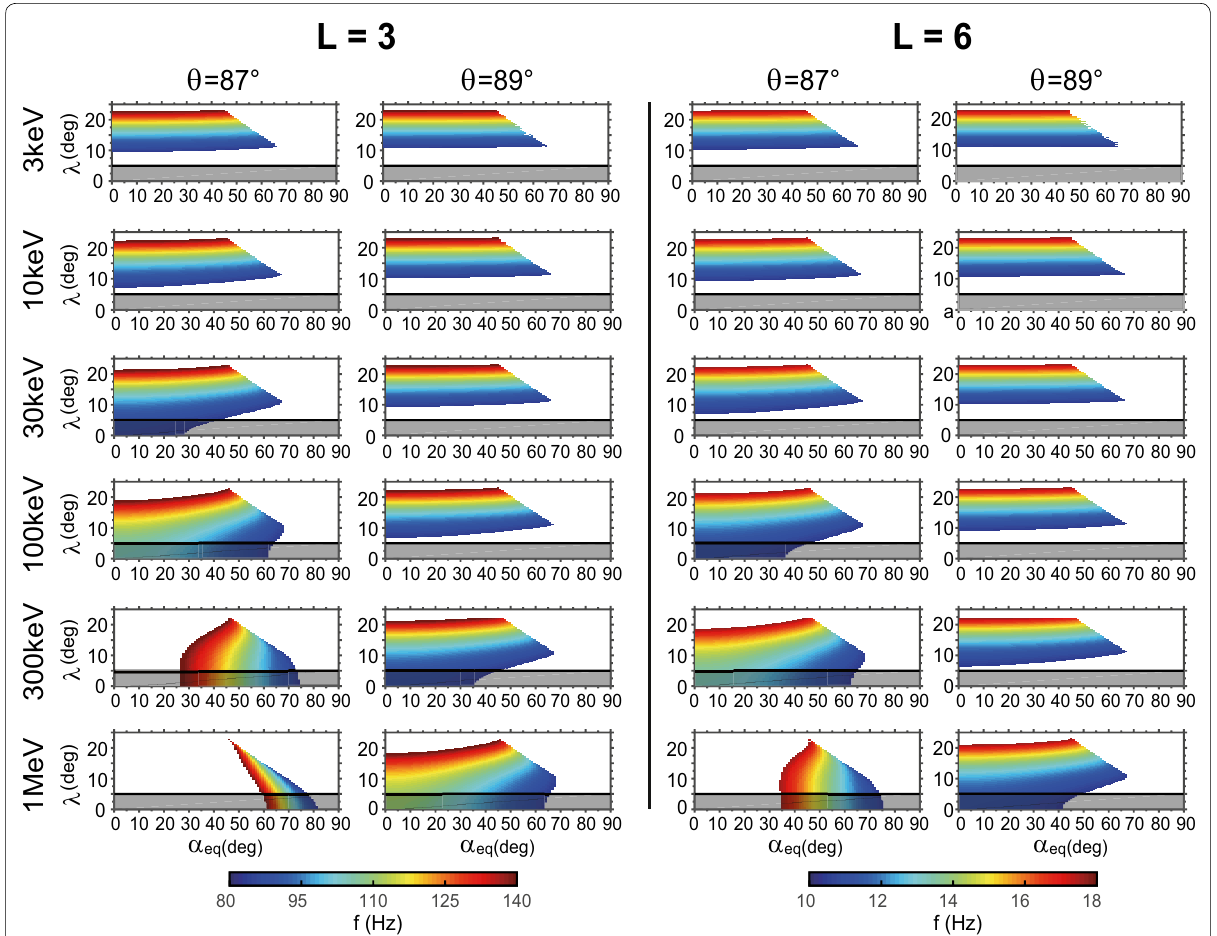
Fig. 4 Regions of resonance in (equatorial pitch angle α eq , magnetic latitude (cid:31) ) space for resonance ( n 4) between magnetosonic waves and = ring current protons at L 3 (inside the plasmasphere) and at L 6 (outside the plasmasphere) for six energies (from top to bottom: 3 keV, 10 keV, = = 30 keV, 100 keV, 300 keV, and 1 MeV) and for two wave normal angles (from left to right θ = 87 ◦ and θ = 89 ◦ ). The wave frequency band is adopted as 0.0026 < ω/(Ω ce ) eq < 0.0044, corresponding to a frequency range of 83–141 Hz at L 3 and 10–18 Hz at L = =